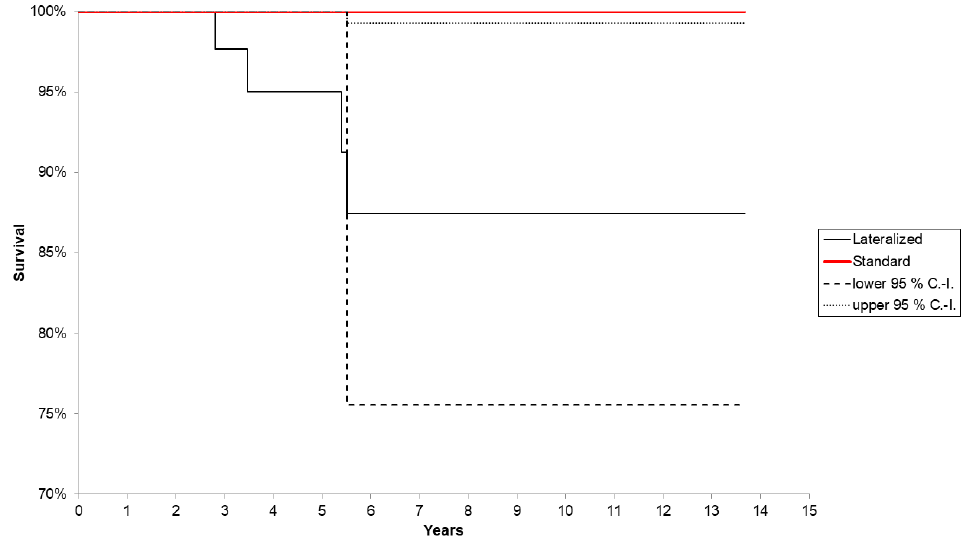
Figure 2. Implant survival with breakage of taper junction as endpoint-lateralized vs. standard offset (log rank p = 0.0283; 95% confidence interval). Table 3. Survivorship analysis.